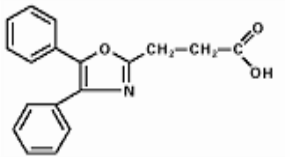
Figure 1 . Chemical structure of